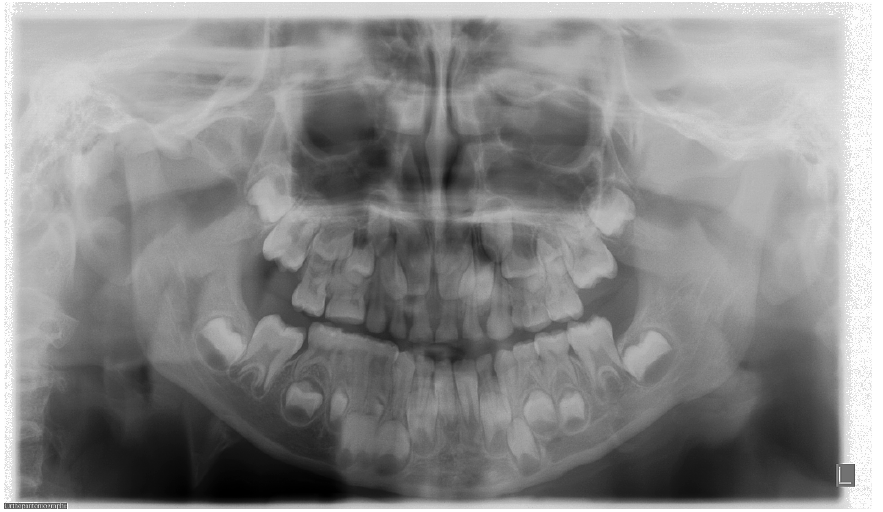
Figure 12. Motion artefact. The movement of a young patient after X-ray tube crosses over their back can be observed as a blurred and distorted image on the mandibular canine/premolar area on the right side.